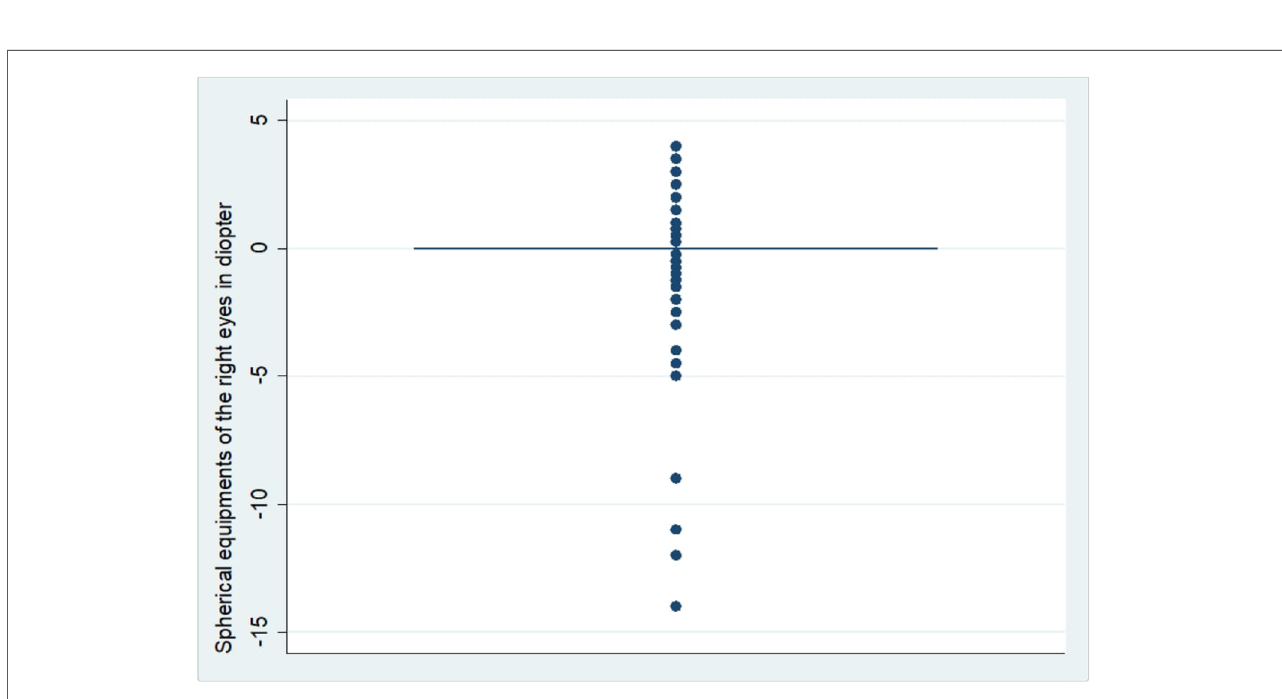
FIGURE 3 Distribution of spherical equivalent on the right eyes of pregnant women ( n